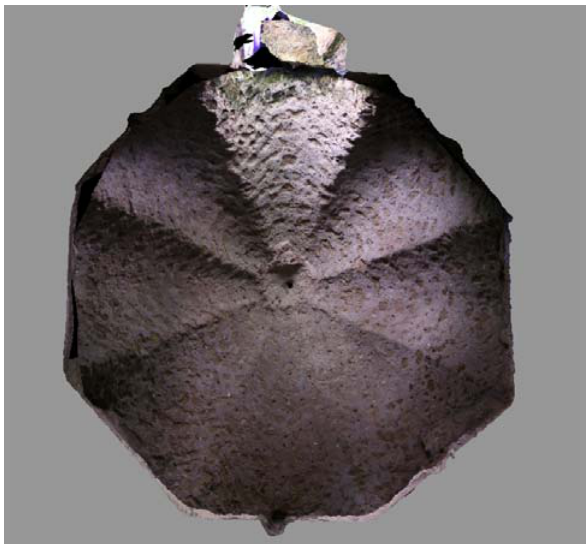
Figure 3. Orthogonal view of the survey model of the dome and texturing.